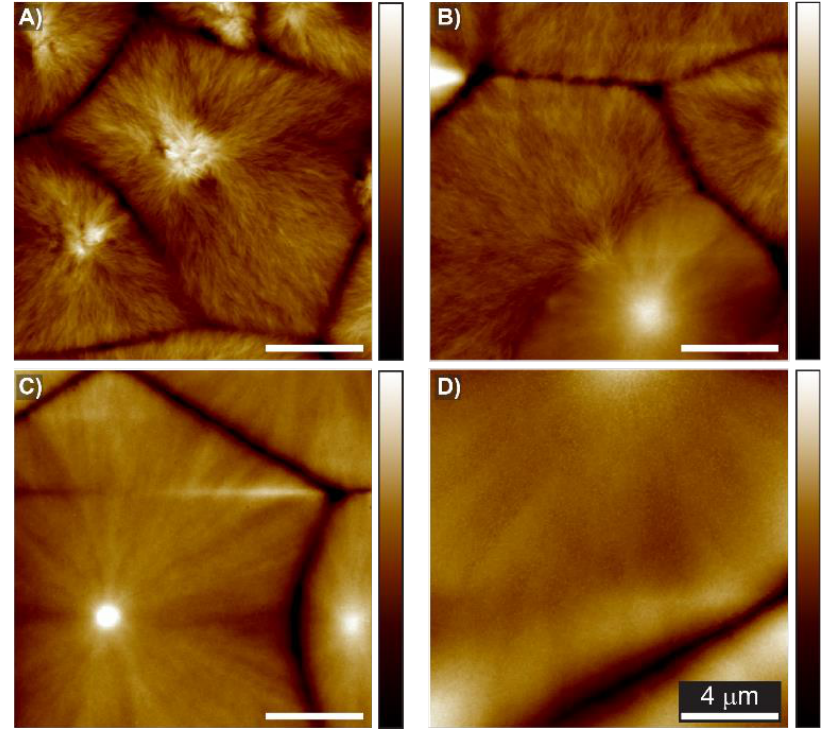
Figure 2. AFM height images of the sample spin-casted from different solutions of polymer – IL: ( A ) 0 wt % IL; ( B ) 10 wt % IL; ( C ) 30 wt % IL; ( D ) 50 wt % IL. A scale bar is applicable to all figures.